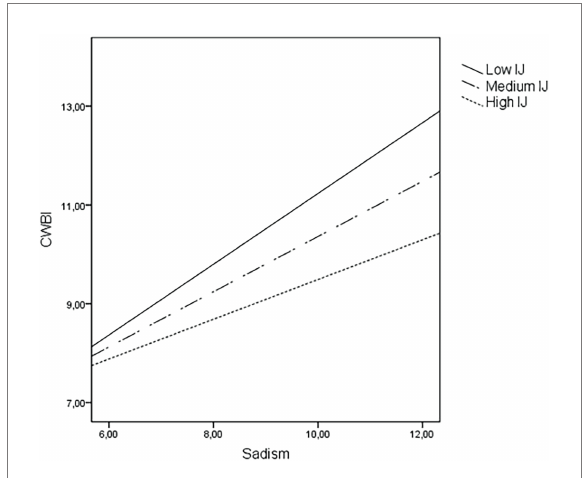
FIGURE 4 Moderating effects of perceived interactional justice (IJ) on the relationship between sadism and counterproductive work behavious targeting indiviauals